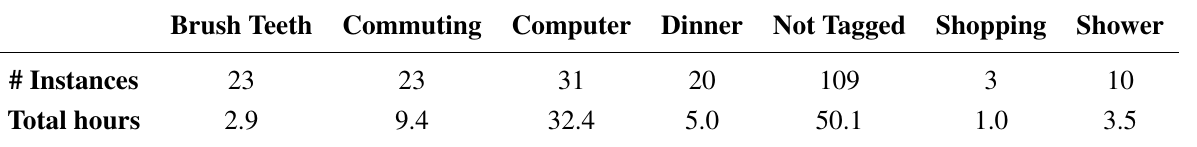
Table 2. Number of instances and duration of each self-reported activity (subject 1).